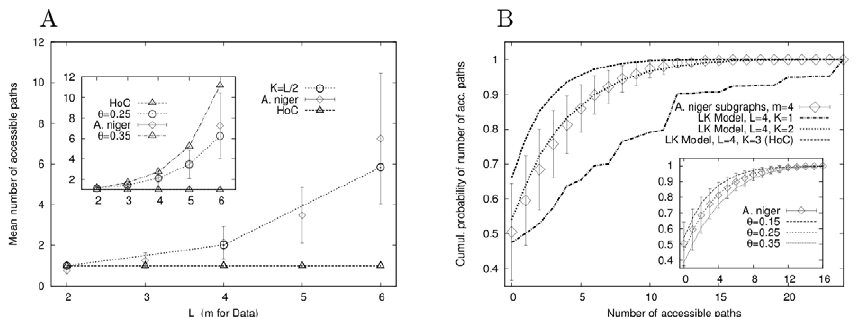
Figure 4. Comparison of models to empirical data. (A) Mean number of accessible paths for HoC, RMF and LK models compared to the empirical A. niger data. With the exception of the HoC model, all curves show an increase of S n L T with L . Both RMF (inset) and LK (main plot) models can be fit to the empirical data. Error bars on the empirical data represent standard deviations obtained from the resampling analysis. (B) Cumulative probability of the number of accessible paths as observed in the empirical fitness landscape compared to LK (main plot) and RMF (inset) model. Error bars represent the standard deviation estimated by the resampling method.